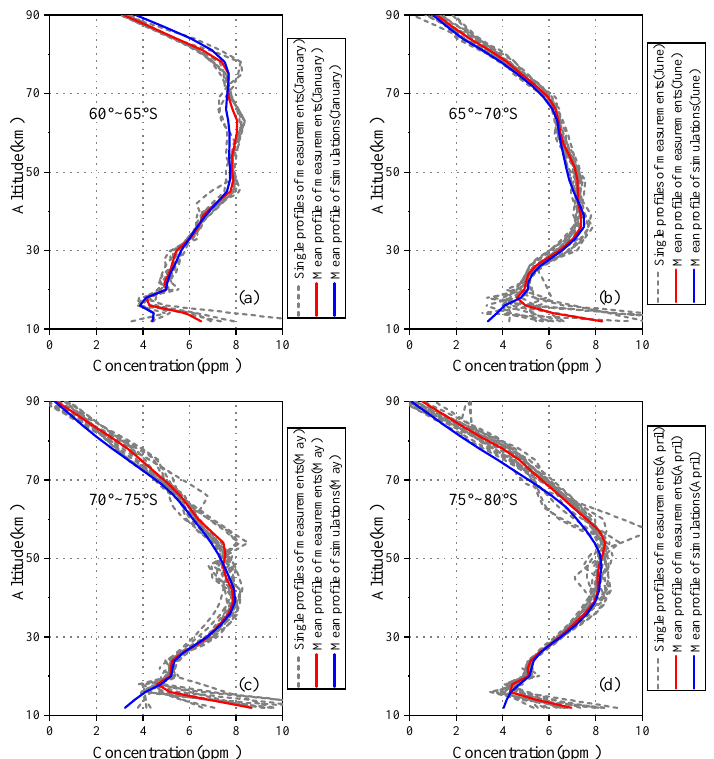
The H 2 O retrievals of representative months (January, June, May, and April) in four latitude regions are presented in Figure 9. The dashed line represents single profile retrieved from AIUS measurements, and the red line represents mean profiles retrieved from AIUS measurements. In general, the vertical distributions of the H 2 O mean profiles were different in different latitude zones and months, especially at the lower stratosphere and upper mesosphere. For 70 ◦ –75 ◦ S and 75 ◦ –80 ◦ S, the single profile distributions were more discrete than that in 60 ◦ –65 ◦ S and 65 ◦ –70 ◦ S, which indicated that the variance of the H 2 O profiles can be larger.